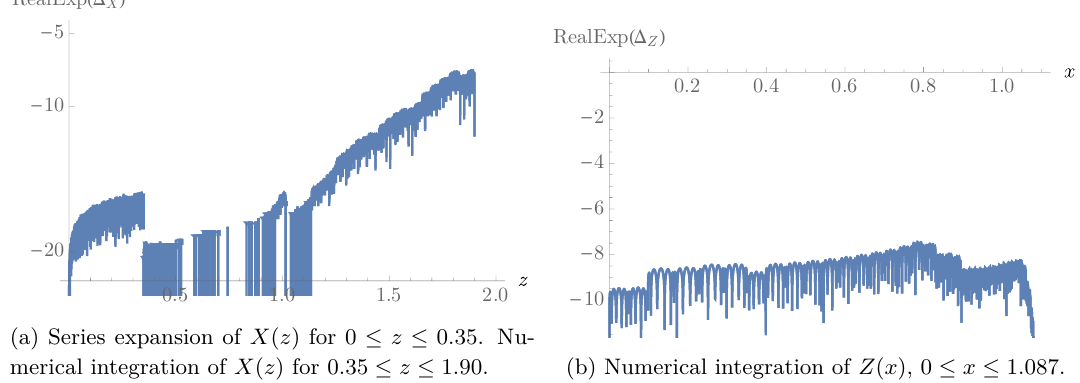
merical integration of X ( z ) for 0 . 35 ≤ z ≤ 1 . 90 . Figure 3 . Order of magnitude of ∆ , the result obtained by evaluating the numerical solution into the corresponding differential equation, for µ = − 0 . 002 in the non-minimal case. Similar plots were obtained for all the other values of µ that were considered, for both prescriptions.